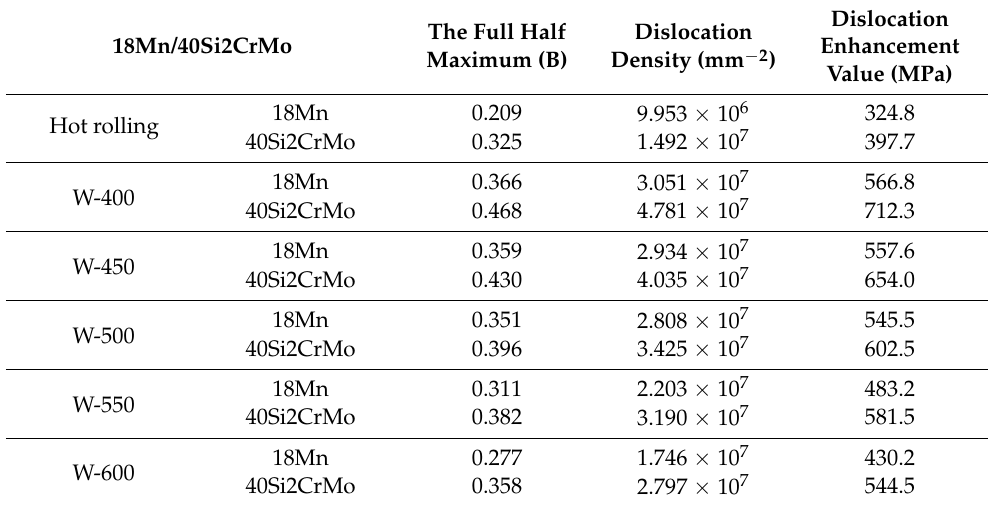
Figure 11. XRD patterns of 18Mn/40Si2CrMo multilayer composite steel plates with different rolling warm temperatures. Table 4. The full width at half maximum, dislocation densities, and dislocation enhancement value for 18Mn/40Si2CrMo multilayer composite steel with different parameters.